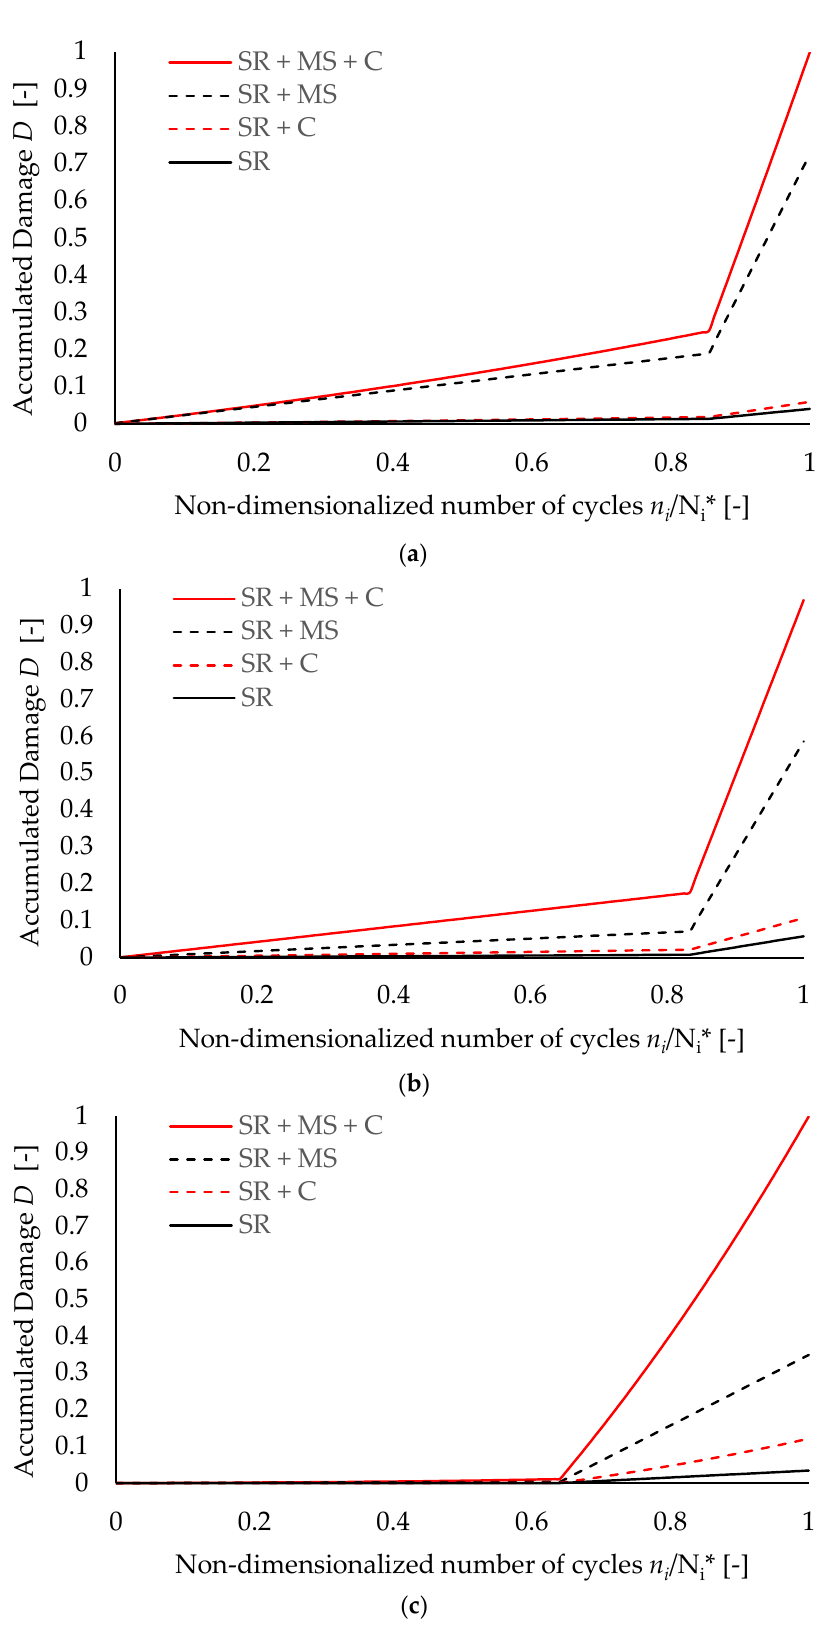
Figure 10. Damage evolution for each test derived by considering/neglecting corrosion and/or mean stress effects: ( a ) specimen S2 ( η * Rd = 4.1%), ( b ) specimen S3 ( η * Rd = 7.7%), and ( c ) specimen S4 ( η * Rd = 13.1%)